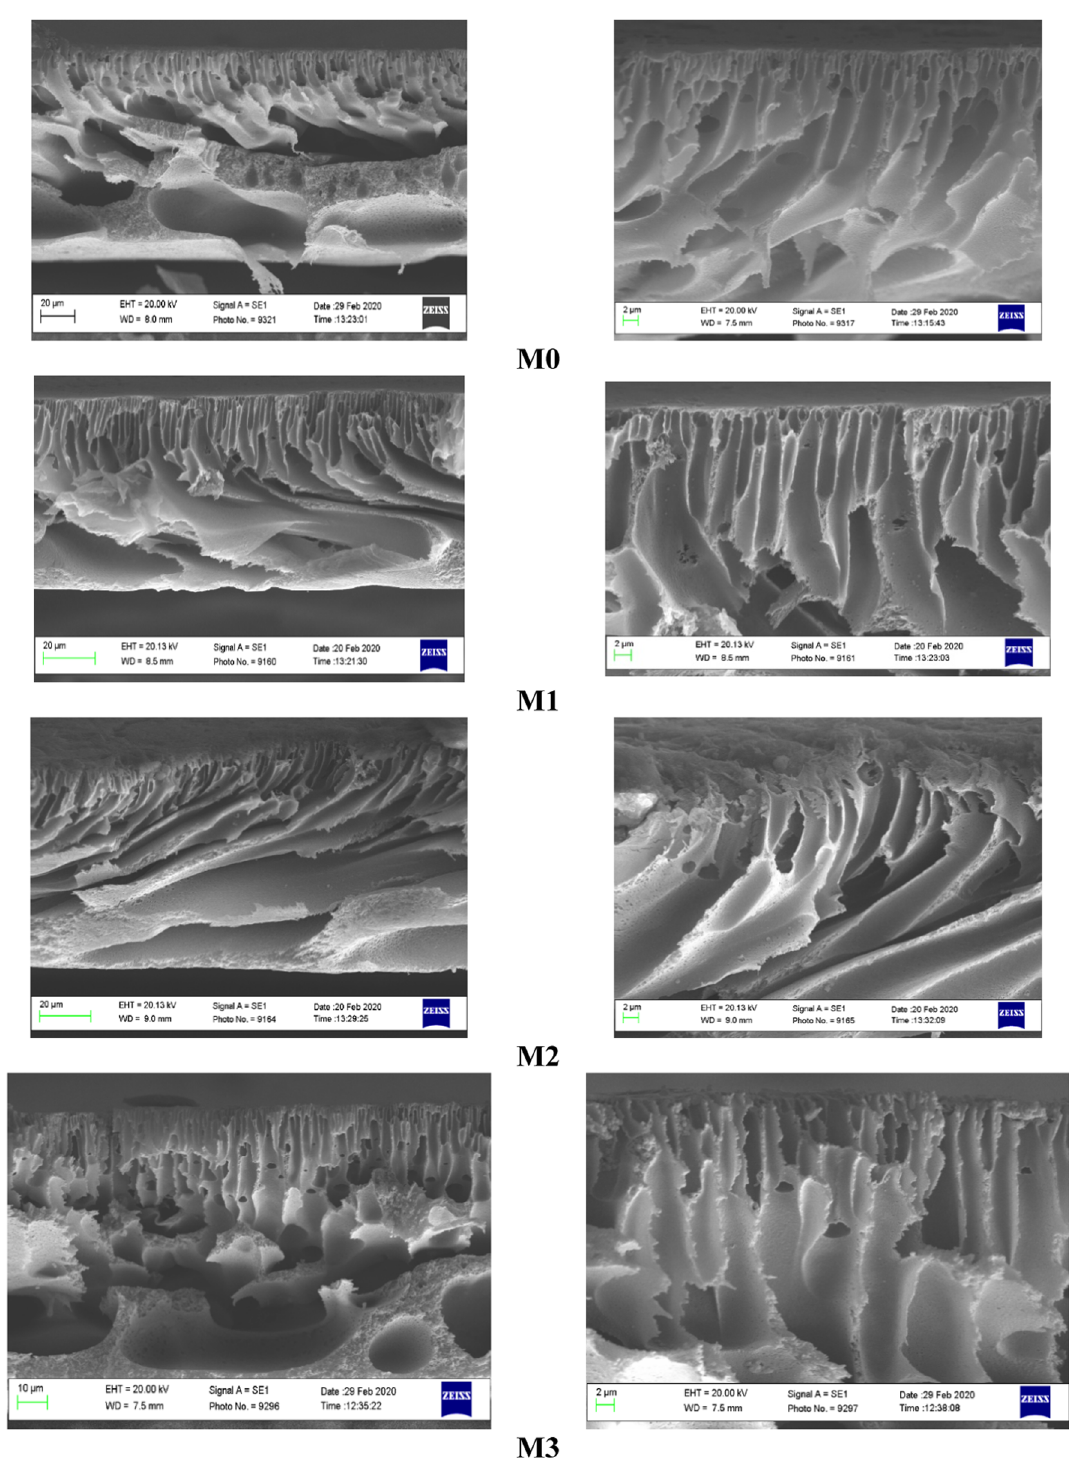
Fig. 4 The effect of transmembrane pressure and temperature on the PWF of the fabricated